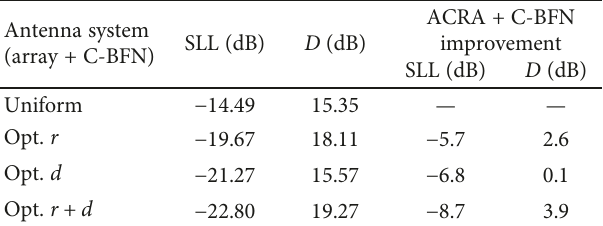
Figure 5: Aperiodic layouts of the concentric ring arrays in each numeric example: (a) optimizing antenna rings ( r ), (b) optimizing antenna elements ( d ), and (c) optimizing antenna elements and rings ( d , r ). Table 1: Results of the numeric experiments presented and mean values of the nonuniformity improvement on the antenna